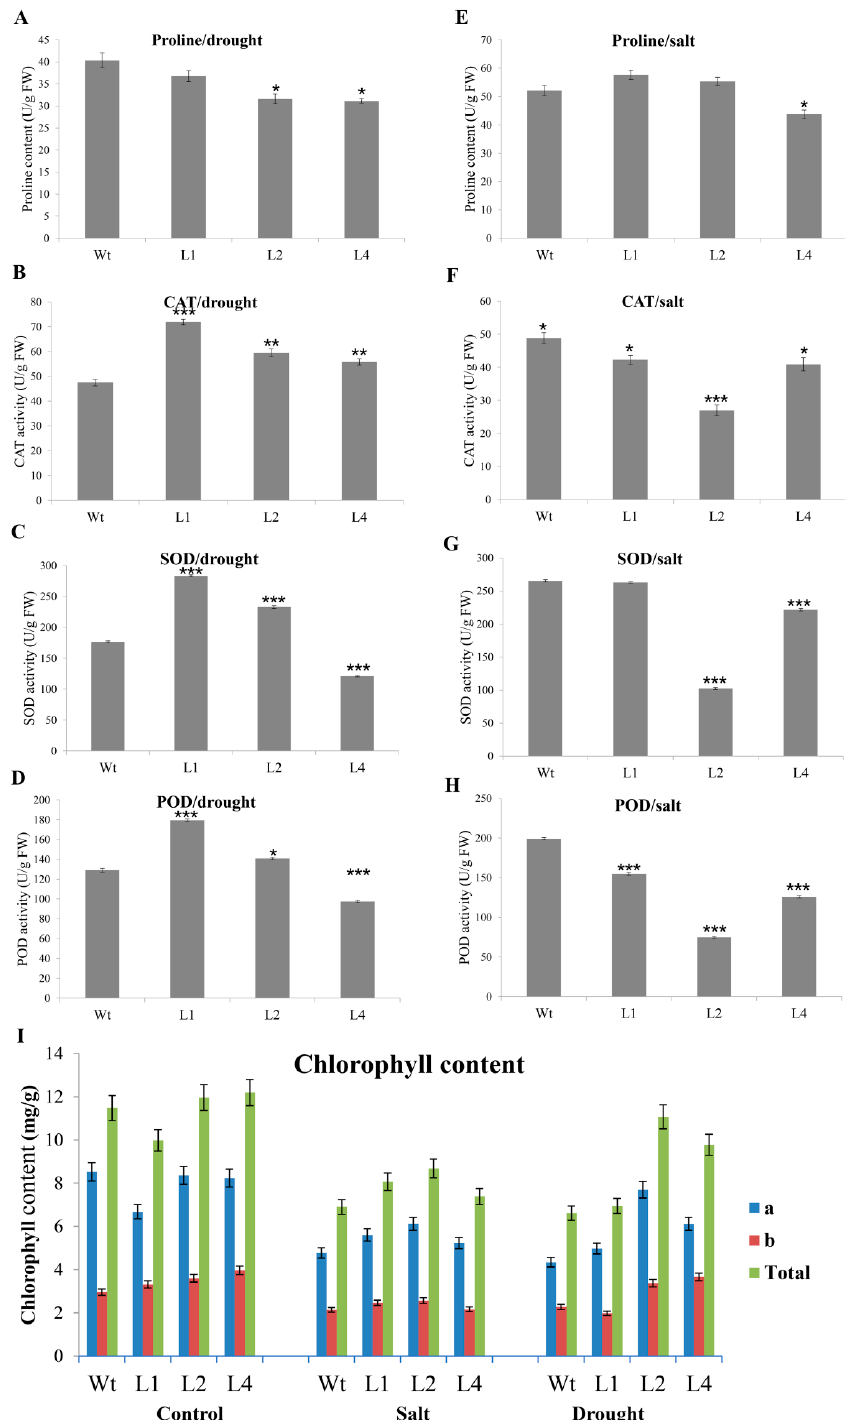
Figure 8. GhTRX134 overexpression increases enzyme activities under drought conditions and proline content under salt stress. Two-week-old plants were treated with ( A – D ) 20% polyethyleneglycol to measurethe proline content, catalase (CAT), superoxide dismutase (SOD), and peroxidase (POD) enzyme activity levels. ( E – H ) 200 mM NaCl to measure proline content, CAT, SOD, and POD enzyme activity levels. ( I ) Chlorophyll content under salt (200 mM NaCl) and drought (PEG 20%). Proline and chlorophyll content were measured after drought and salt for 5 days using aspectrophotometer. The values represent the means of three replicates ± SDs. Student’s t -test was used to determine significant di ff erences (* p < 0.05; ** p < 0.01; and *** p < 0.001) compared to the control